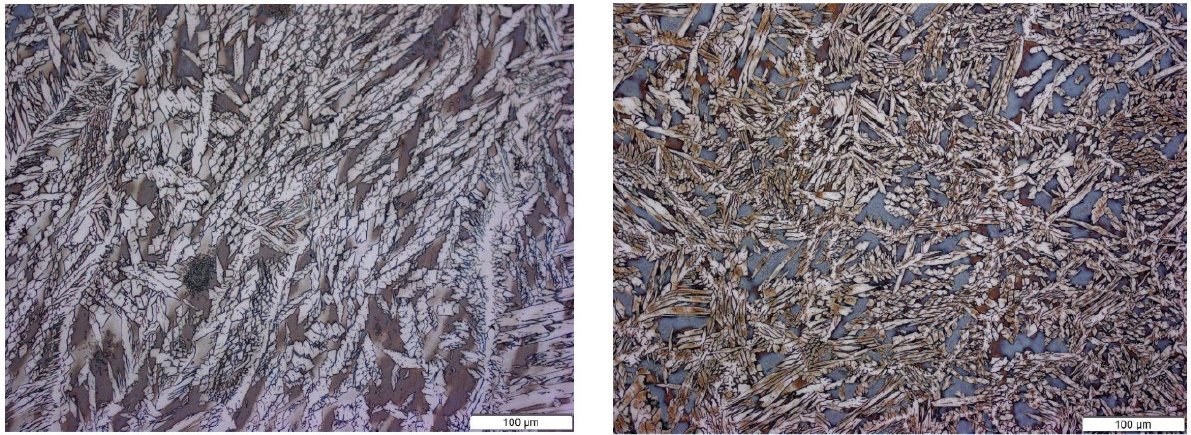
Figure 4. Microstructures of longitudinal ( left ) and transverse ( right ) layered directions showing ferrite volume fraction of ~36%.